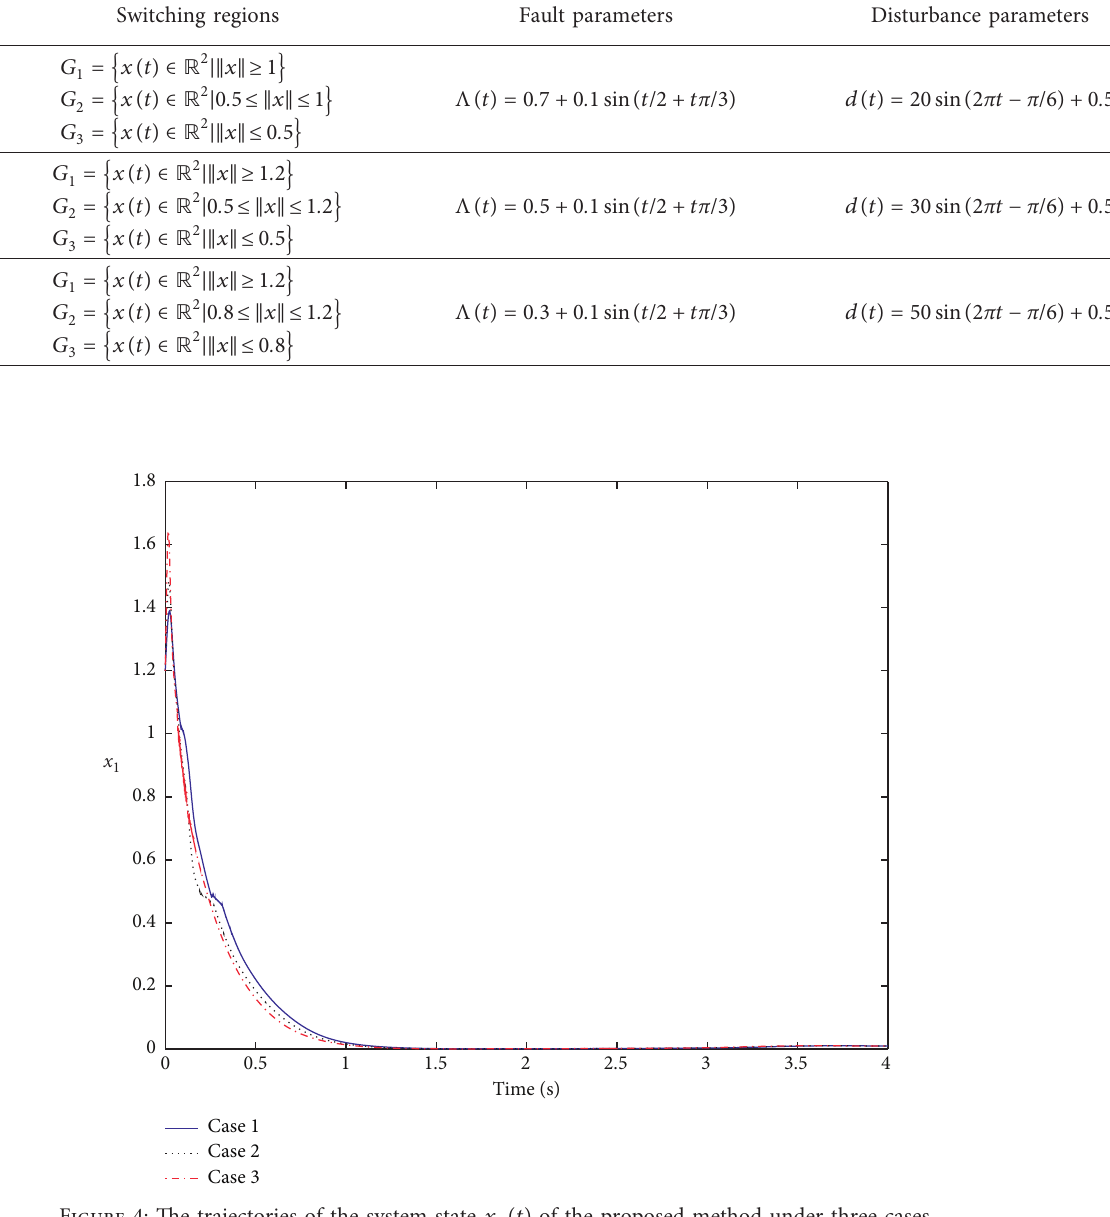
( t ) of the proposed method under three 1